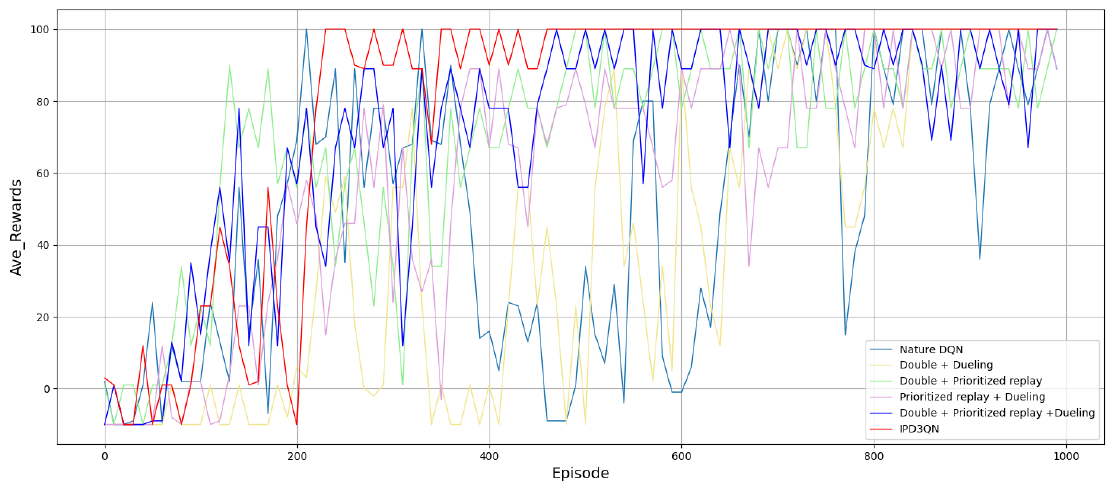
Figure 4. Comparison Of Different Algorithms In Maze